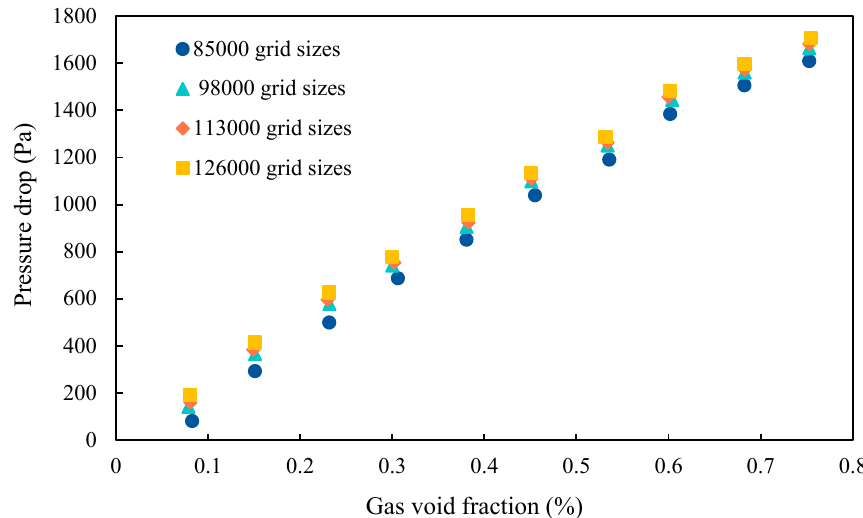
Figure 4. Simulated pressure drop along the tubing at four grid sizes.